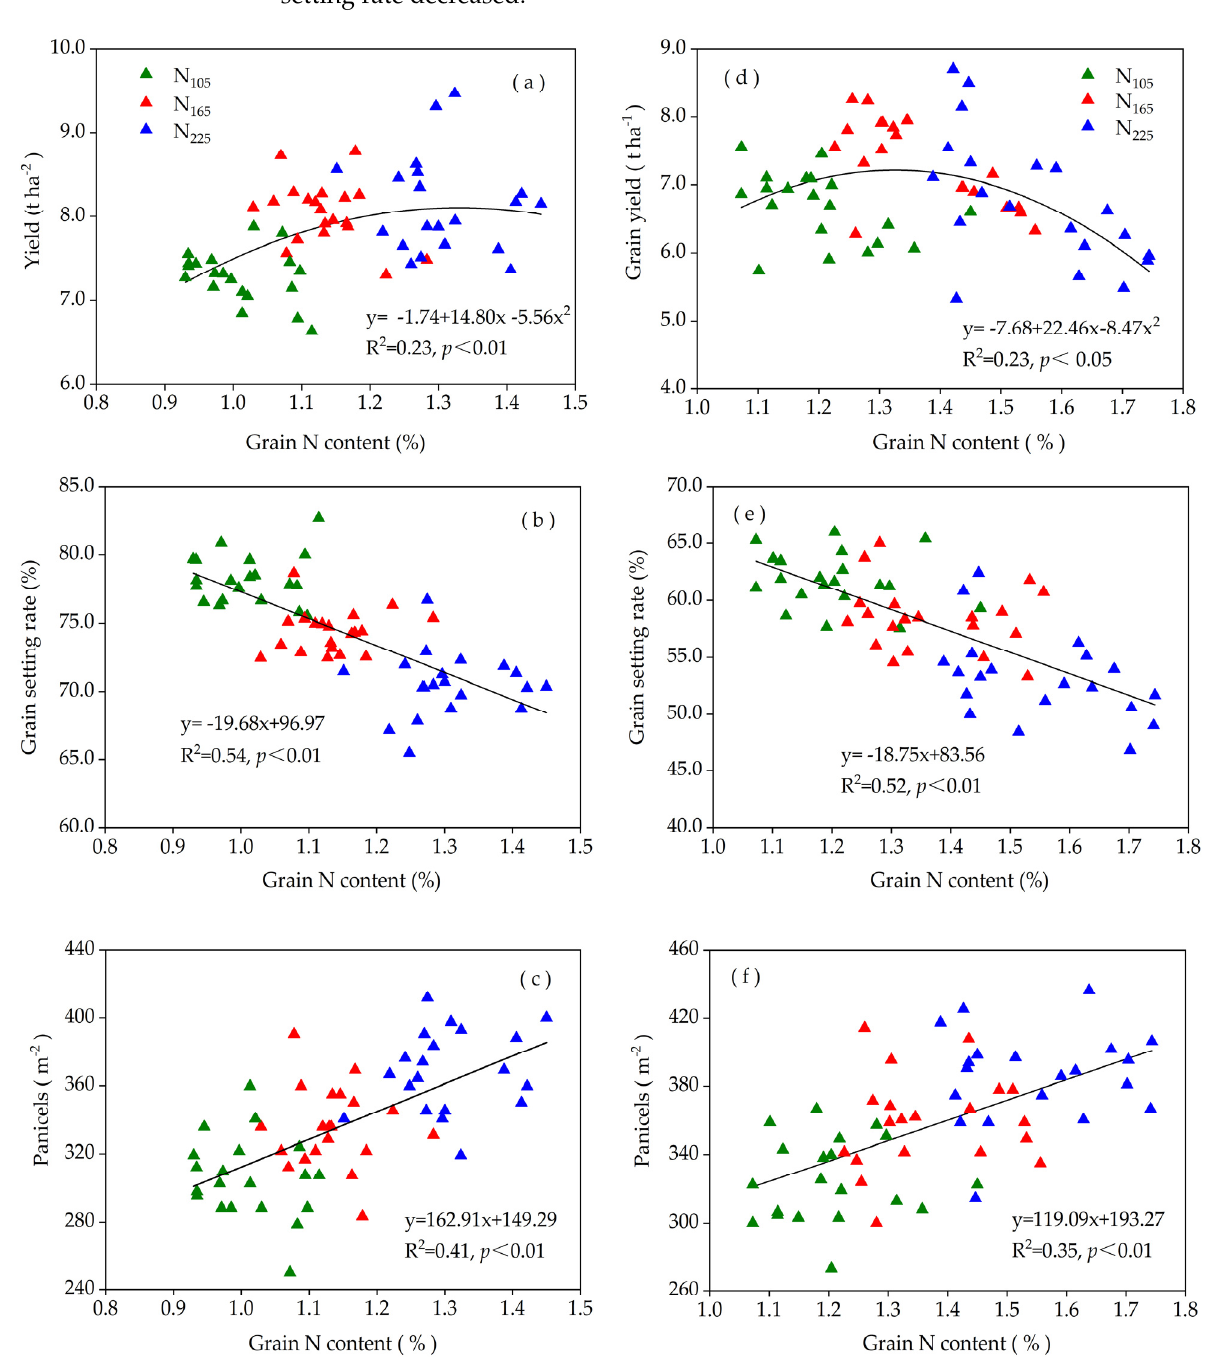
In the field experiments, there was a significant quadratic relationship between grain yield and grain N content, while panicles m − 2 and grain setting rate had a positive and a negative linear correlation with grain N content, respectively, in both 2019 and 2020 (Figure 3). Except for the same coefficient of determination (R 2 ) of grain yield and grain N Note: N 105 , N 165 , and N 225 indicate N application rate of 105, 165, and 225 kg ha − 1 , respectively. Within content (0.23), the coefficients of determination (R 2 ) of panicles m − 2 and grain setting rate a column, different lowercase letters between varieties in the same N application rate indicate sig- with grain N content in 2019, respectively, were larger than those in 2020. The panicles m − 2 nificant differences at the p < 0.05 level. Different uppercase letters between different N application increased with the increase of grain N content at three N application rates, while the grain rates in the same year indicate significant differences at the p < 0.05 level. setting rate decreased.